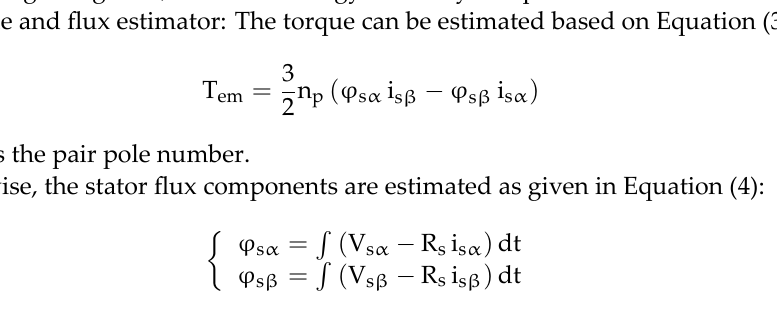
Figure 1. DTC structure of IM fed with three‑level inverter. Referring to Figure 1, the DTC strategy is mainly composed of three